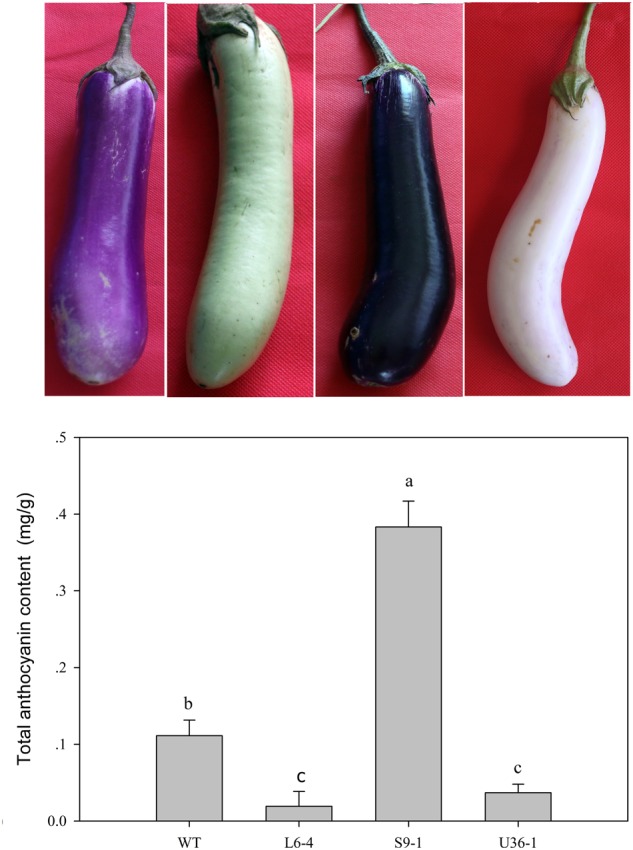
Total anthocyanin content change in the M2 generation. WT fruit showed the purple color, the S9-1 mutant showed purple black color, the L6-4 mutant showed green fruit color, the U36-1 mutant showed the white color. Statistical significance of the differences between samples was calculated with ANOVA by paired-group comparisons. Different letters indicate significance at P < 0.05.